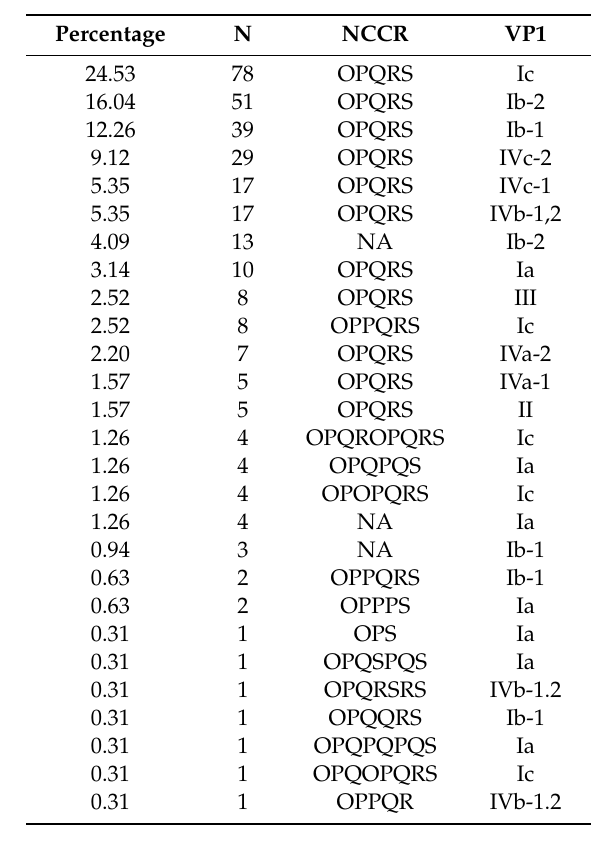
Table 4. The abundance of BKPyV genome neighbors based on combined NCCR and VP1 genotyping. Percentage, absolute number of sequences (N), NCCR structure, and VP1 group are provided as columns. NA denoted not available.